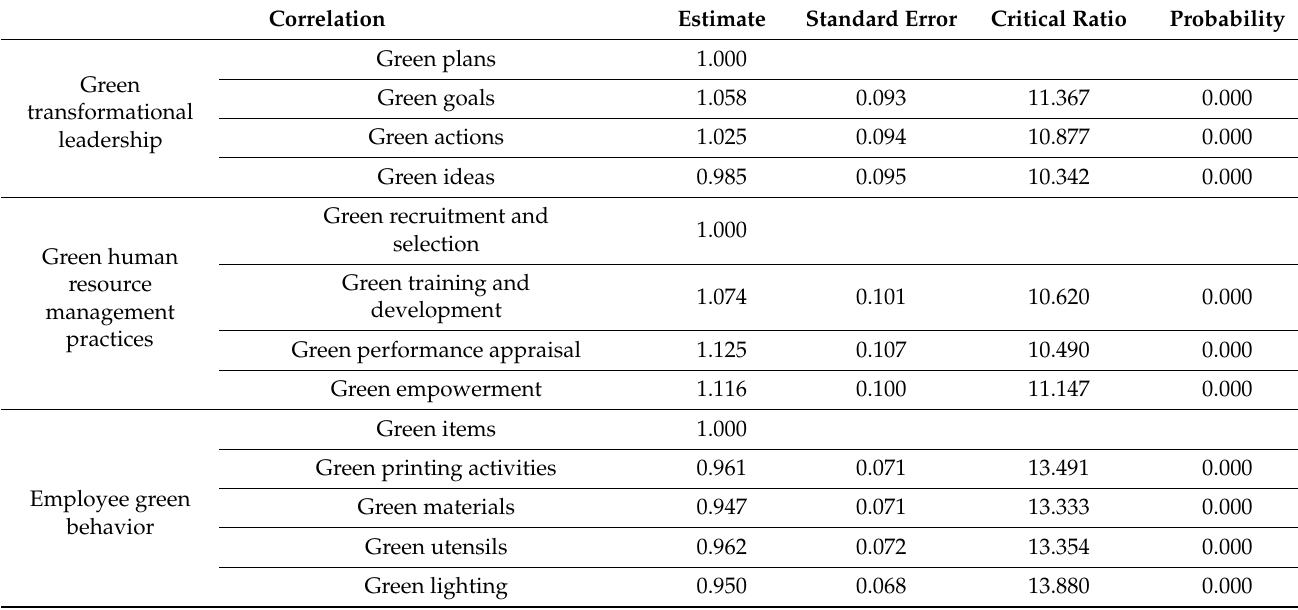
Table 1. Standardized regression